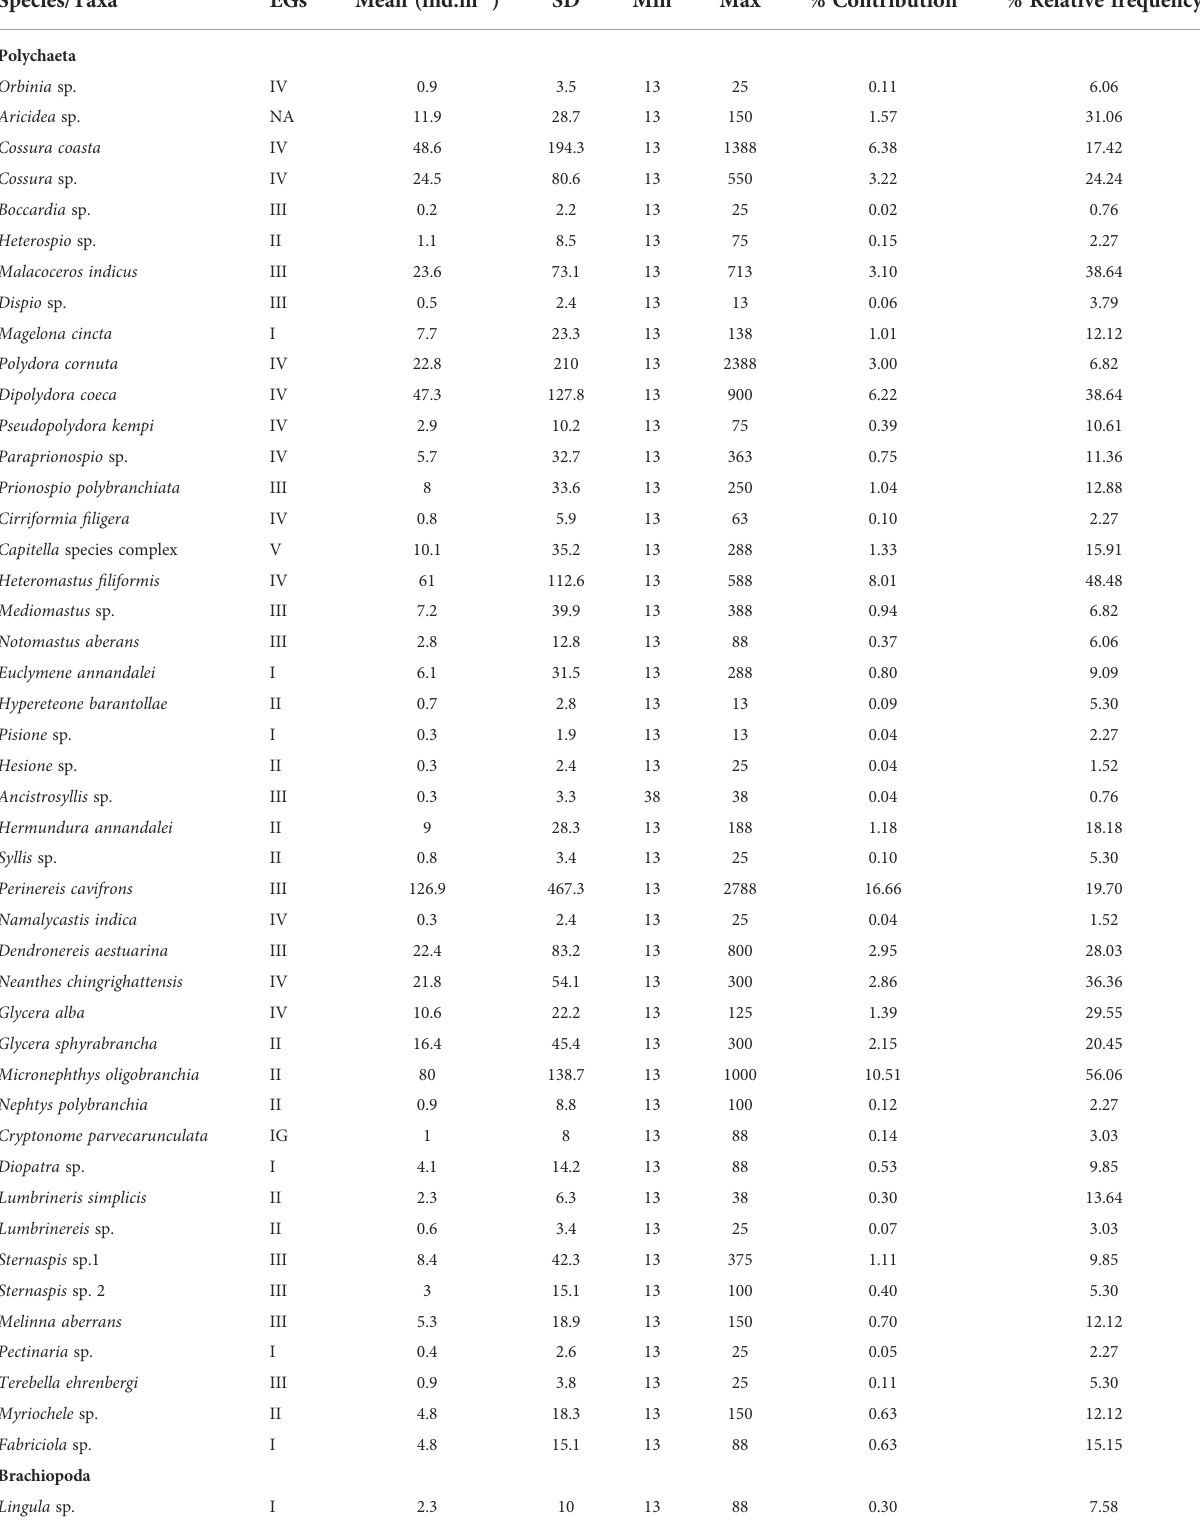
TABLE 2 Numerical abundance of macrobenthic fauna and their assignment to ecological groups (EGs-Ecological groups, NA-Not assigned, IG-Ignored, SD-standard deviation). Species/Taxa EGs Mean (ind.m -2 ) SD Min Max % Contribution % Relative frequency Polychaeta Orbinia sp. Aricidea sp.